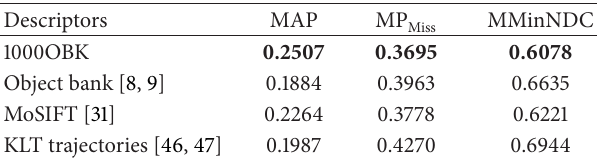
Table 1: Comparison of different descriptors for average perfor- mance on TRECVID MED 2012